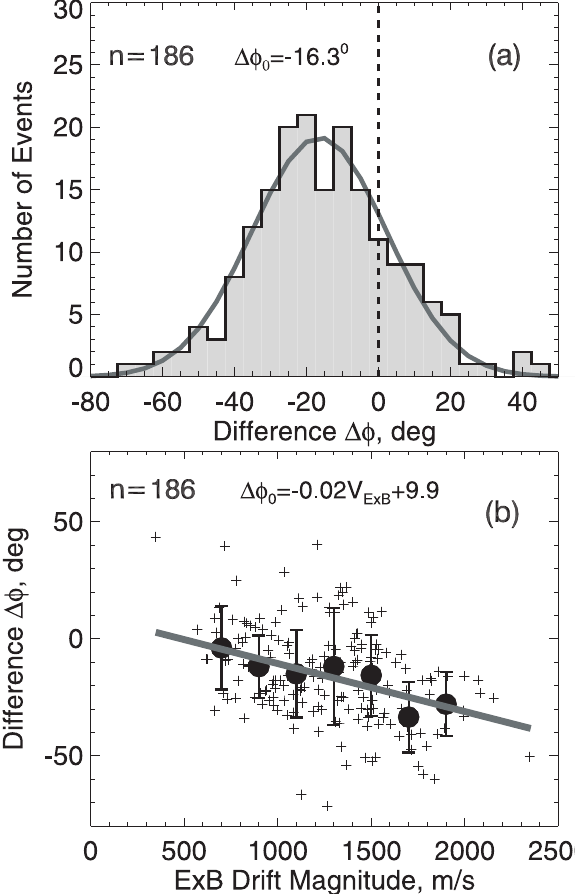
Fig. 10. (a) Occurrence histogram for the difference in the azimuth between the direction of the E × B drift magnitude and the E-region velocity maximum ( 1φ) . Maximum of the Gaussian fit to the his- togram occurs at − 16.3 ◦ . (b) Scatter plot of 1φ versus the E × B drift magnitude. Solid dots with bars represent binned values and standard deviations within each bin. Also shown are a linear fit line and its